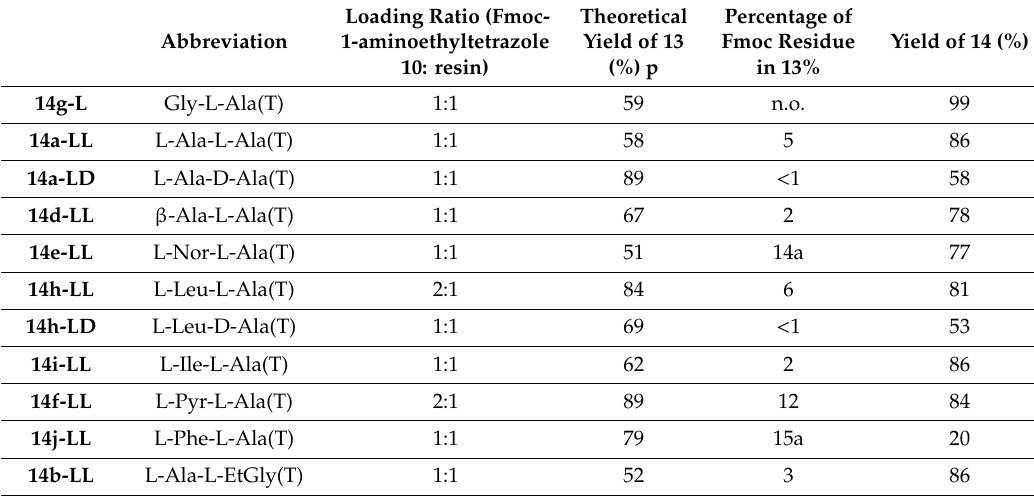
Table 1. Yields and conditions for Scheme 3: Abbreviations: p: the cleaved mixture was triturated and washed with petroleum ether 40–60 ◦ C before yield and impurity calculation; n.o.: not observed; a: the loading was possibly inhomogeneous, and might have been washed with an insu ffi cient amount of piperidine in DMF.